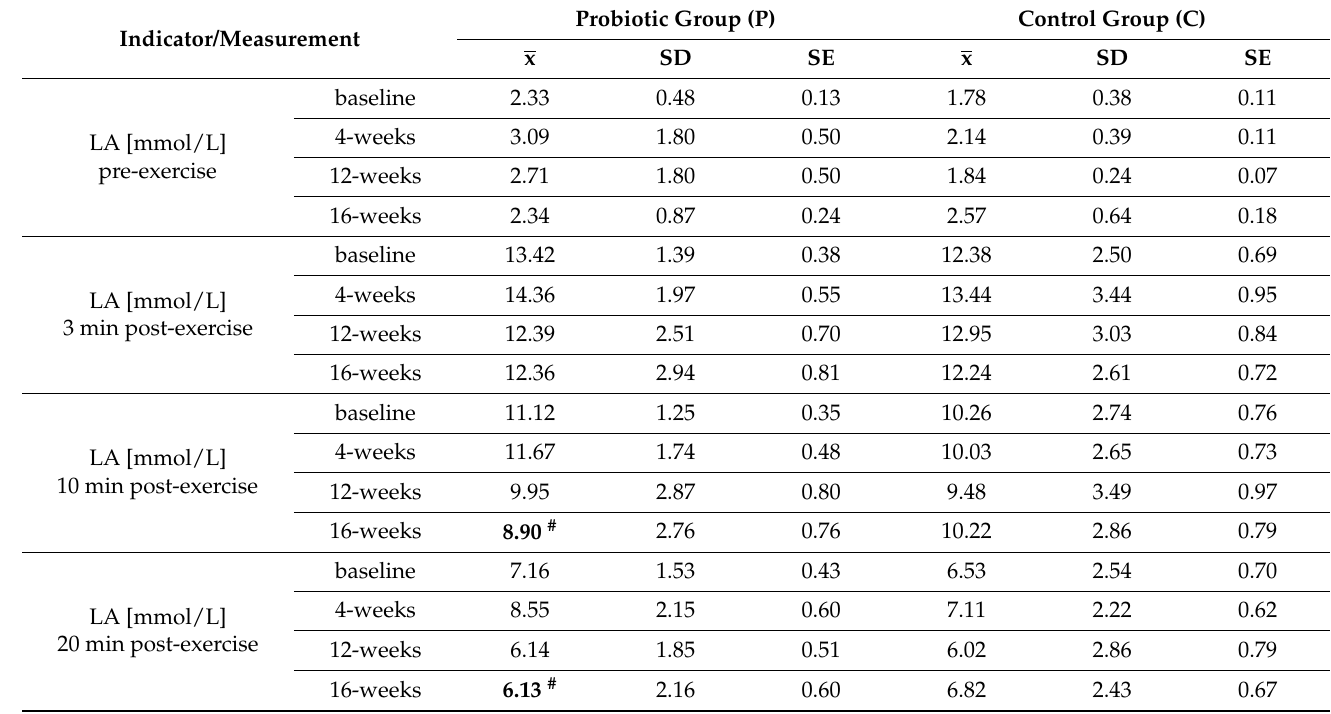
Table 2. The blood lactate concentrations at baseline, 3, 10, and 20 min post-aerobic testing at follow-up measurements during supplementation intervention.